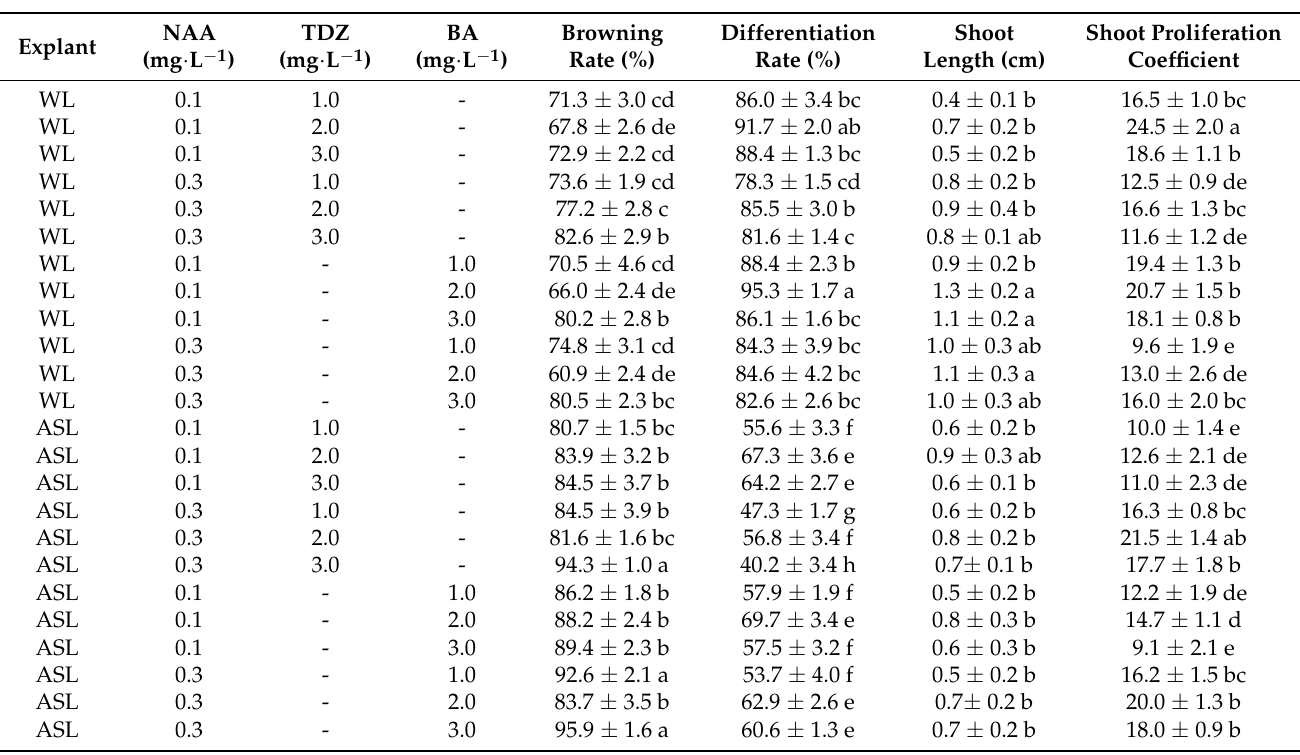
Table 2. Effect of plant growth regulators on shoot proliferation from leaf explants o Sinningia hybrida ‘Isa’s Murmur’.